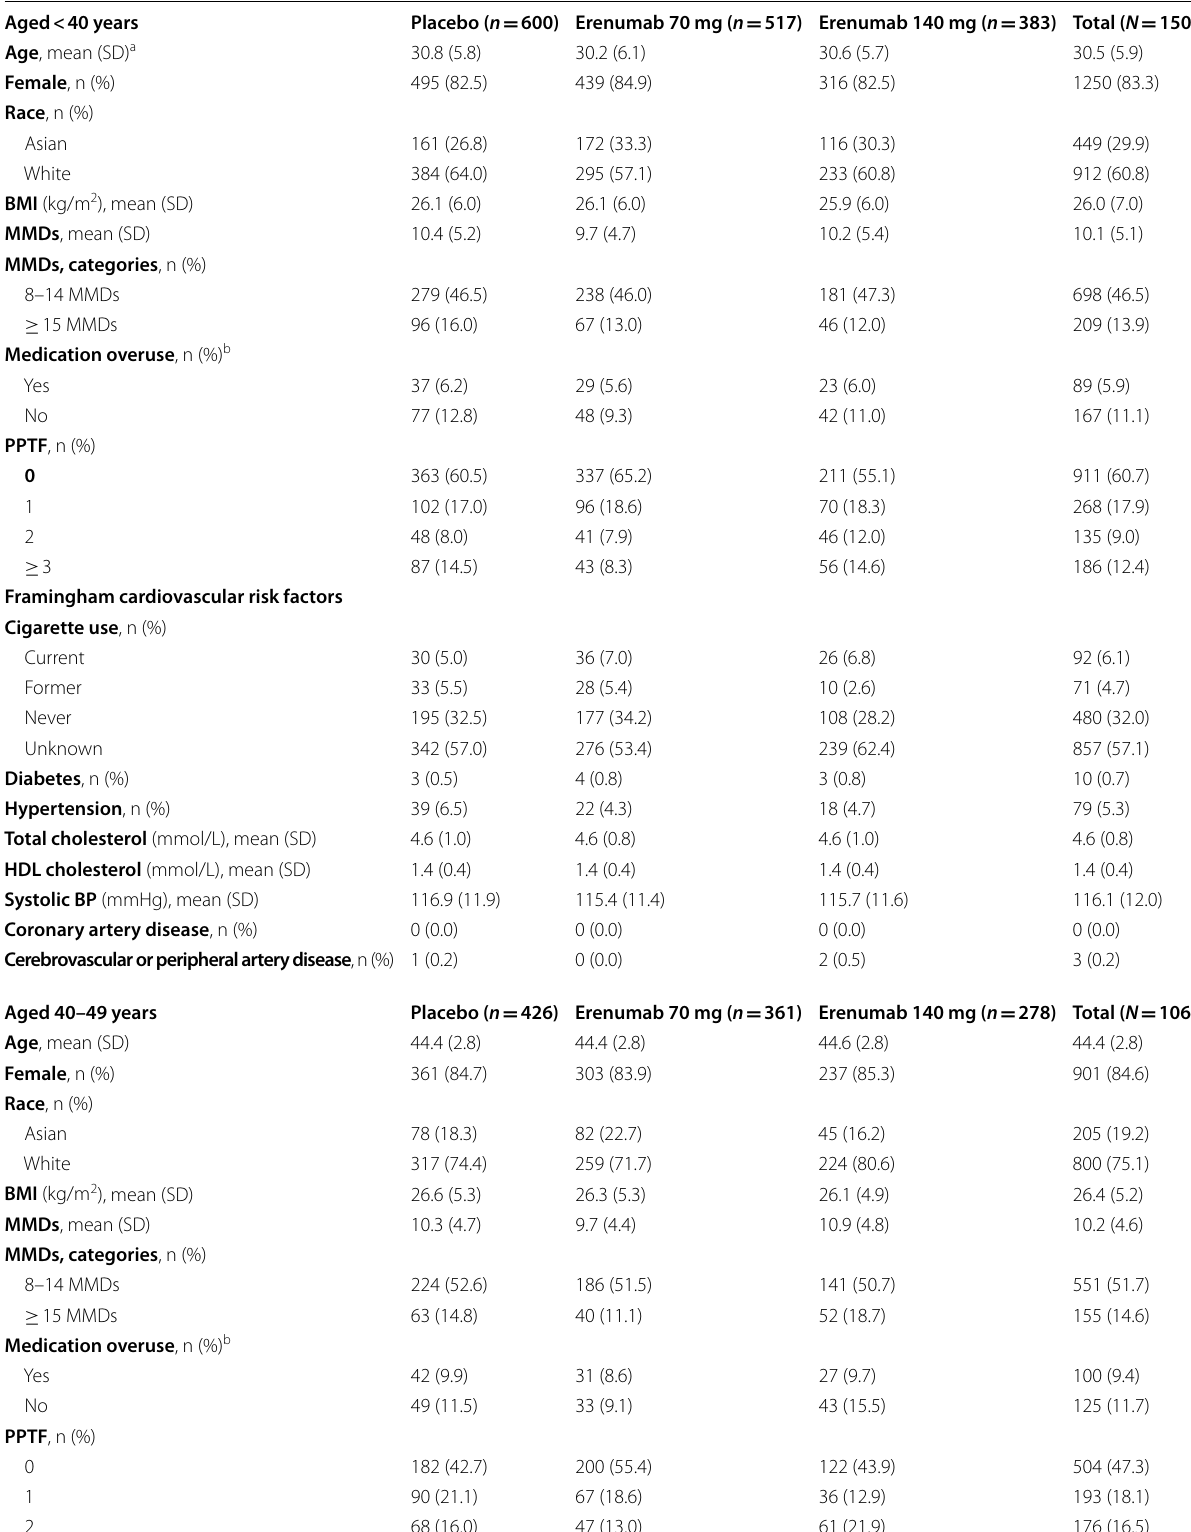
Table 1 Demographics and baseline characteristics stratified by age group Aged < 40